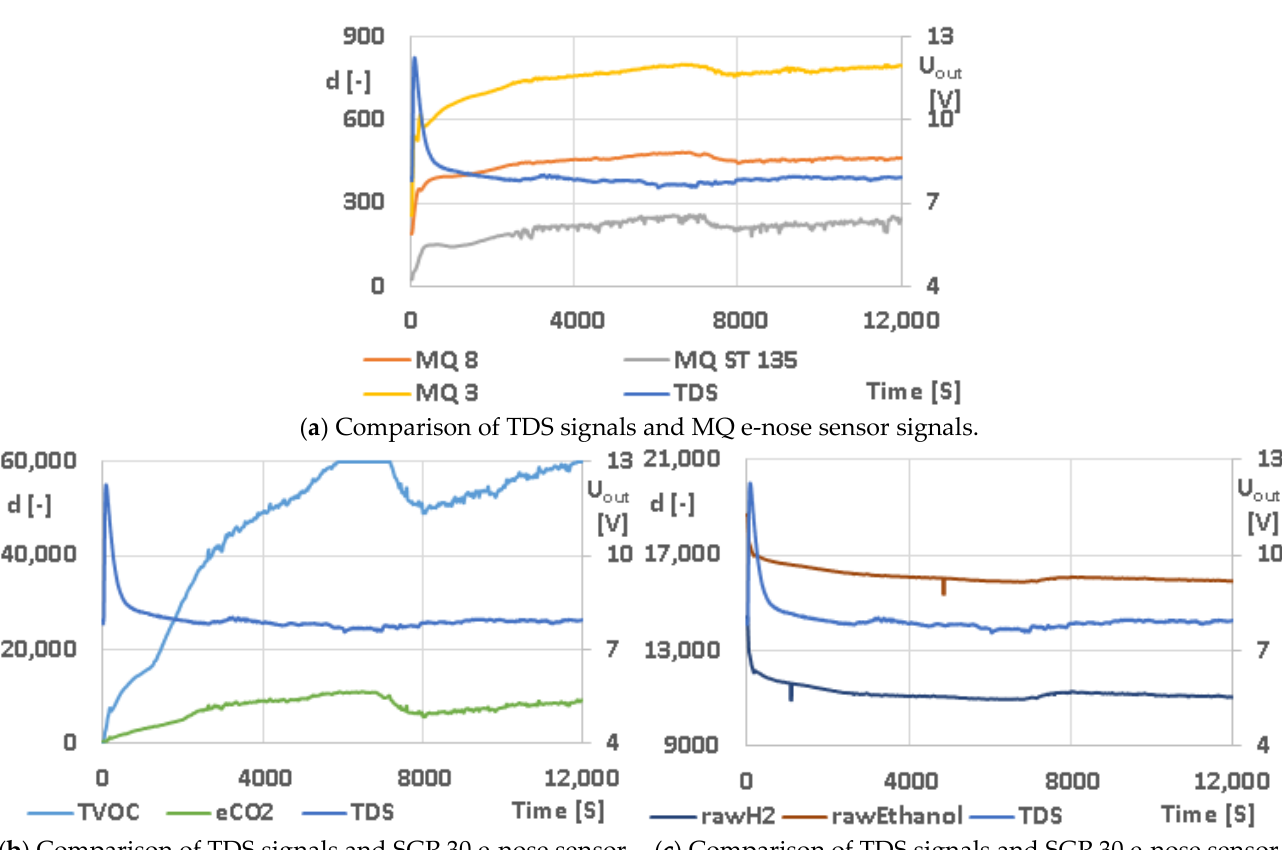
( b ) Comparison of TDS signals and SGP 30 e-nose sensor ( c ) Comparison of TDS signals and SGP 30 e-nose sensor signals (TVOC, eCO 2 ). signals (raw signals for H 2 and ethanol). Figure 10. Co-0% gluten-free dough leavening—example of using the combined system of TDS and